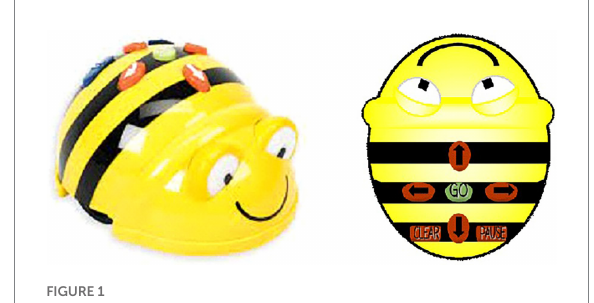
FIGURE 1 A Bee-Bot floor programmable